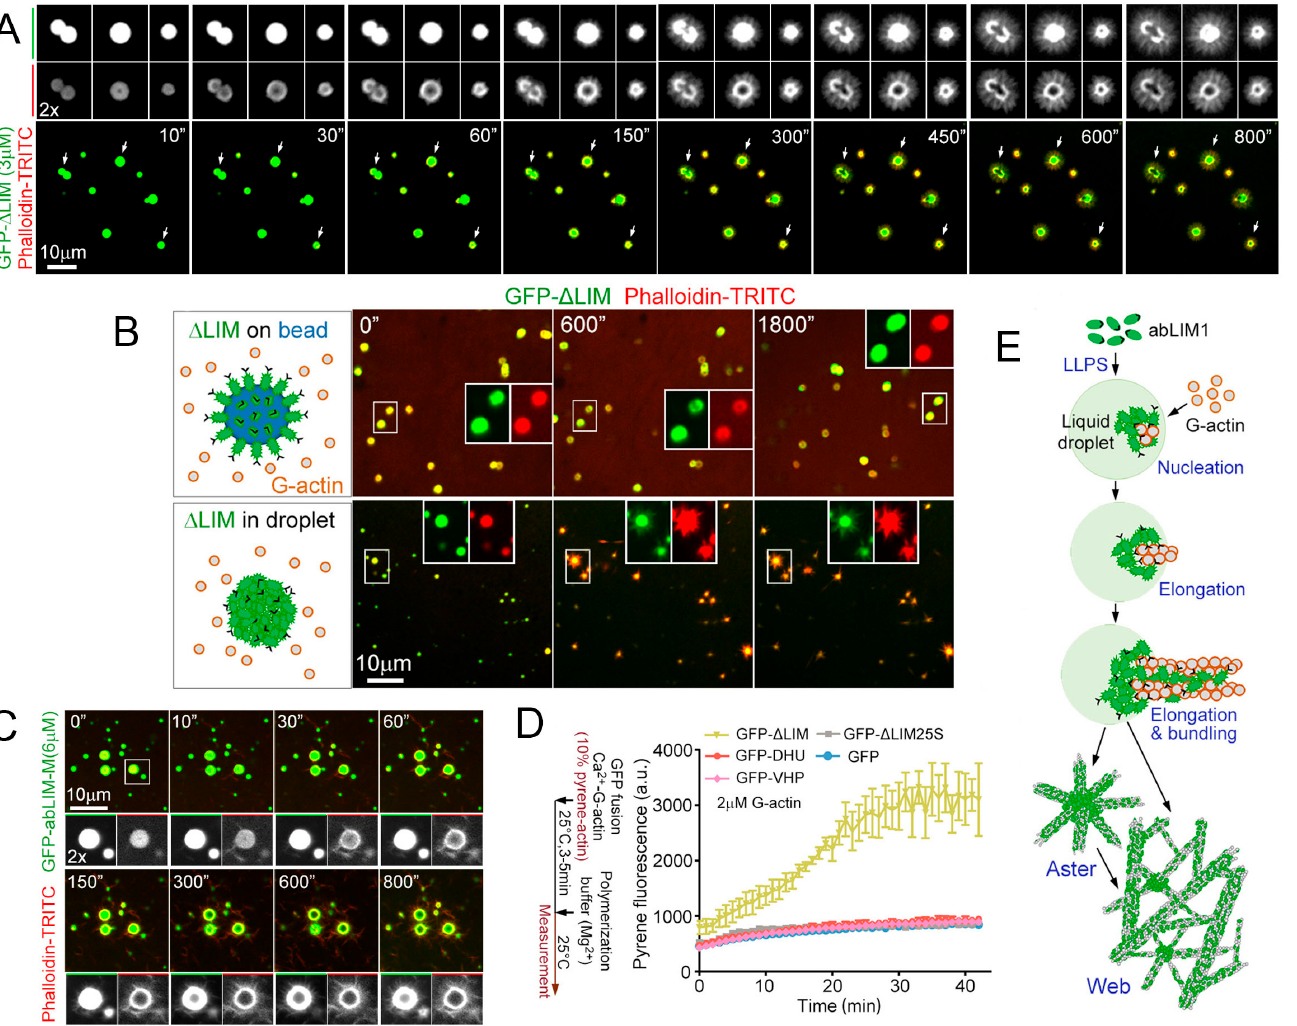
Figure 3. Nucleation, elongation of polymerization, formation of asters, and F-actin filaments in the presence of ∆ LIM or abLIM-M liquid droplets. ( A ) Intense actin polymerization from GFP- ∆ LIM liquid droplets in real time. The initial moment of time was taken as the time when G-actin was introduced into the actin polymerization buffer containing preliminarily formed GFP- ∆ LIM liquid drops. ( B ) F-actin does not polymerize from GFP- ∆ LIM immobilized with an anti-GFP antibody on magnetic beads (upper panel); however, in the presence of preformed His-GFP- ∆ LIM droplets, actin filaments grow rapidly (lower panel). ( C ) abLIM-M liquid droplets can also generate asters. Although the LIM domain inhibits droplet formation, GFP-abLIM-M forms droplets in the presence of 1% PEG. Drops of GFP-abLIM-M, as well as GFP- ∆ LIM, induce aster formation after the addition of G-actin. ( D ) G-actin polymerization requires the presence of GFP- ∆ LIM or GFP-abLIM-M droplets. Individually, neither GFP-DHU (IDR domain) nor GFP-VHP (actin-binding domain) affects the rate of actin polymerization. ( E ) A model illustrating the role of abLIM1 in actin polymerization. At least, its abLIM-S or abLIM-M isoform undergoes LLPS to form condensates that promote actin concentration, initiate polymerization, and cross-link actin filaments to form asters and sporadic bundles that further develop into the F-actin web. The figure represents panels B, E, and G of Figure 4 and panels C and F of Figure 5 of Yang et al., PNAS 119 (29), e2122420119, 2022, [27]. Copyright © 2022 Yang et al., published by PNAS. This article is distributed under Creative Commons Attribution- NonCommercial-NoDerivatives License 4.0 (CC